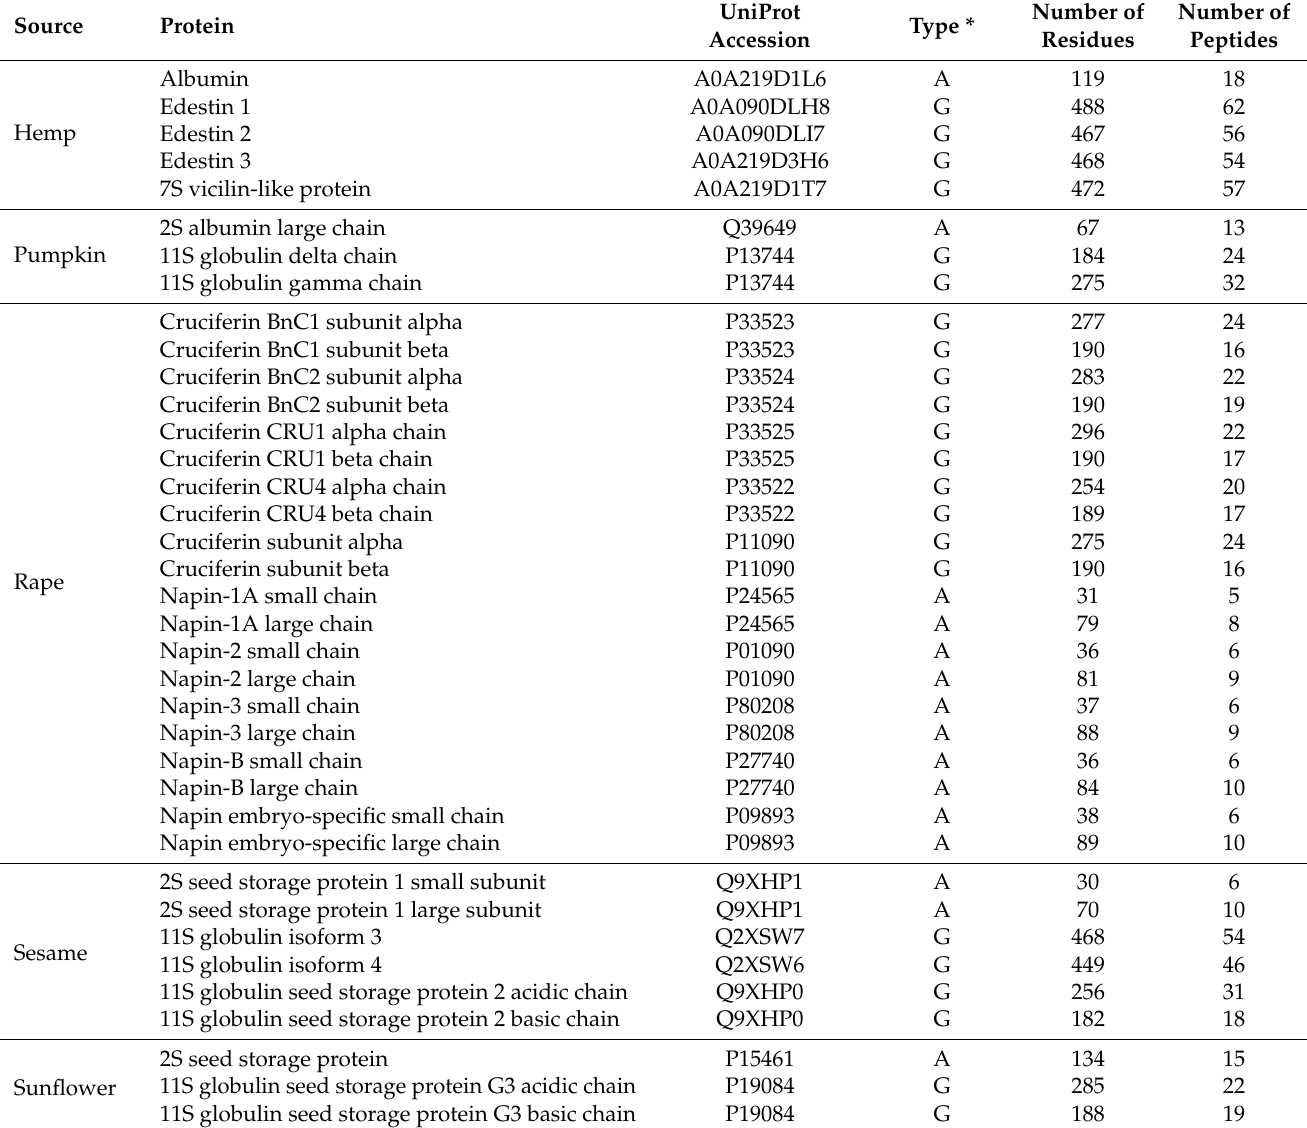
Table 1. Numbers of peptide fragments released from major oilseed proteins by in silico trypsin hydrolysis.